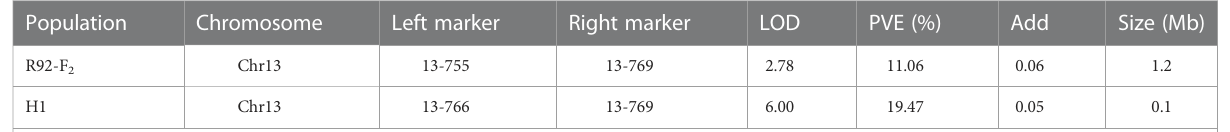
TABLE 3 Mapping of PoFSP QTLs by secondary segregated population ICIM.